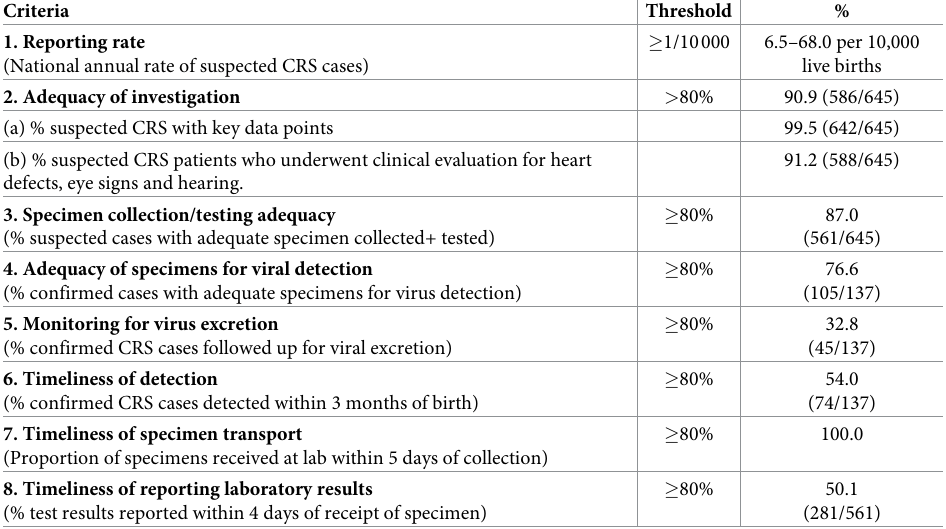
Table 3. Surveillance quality